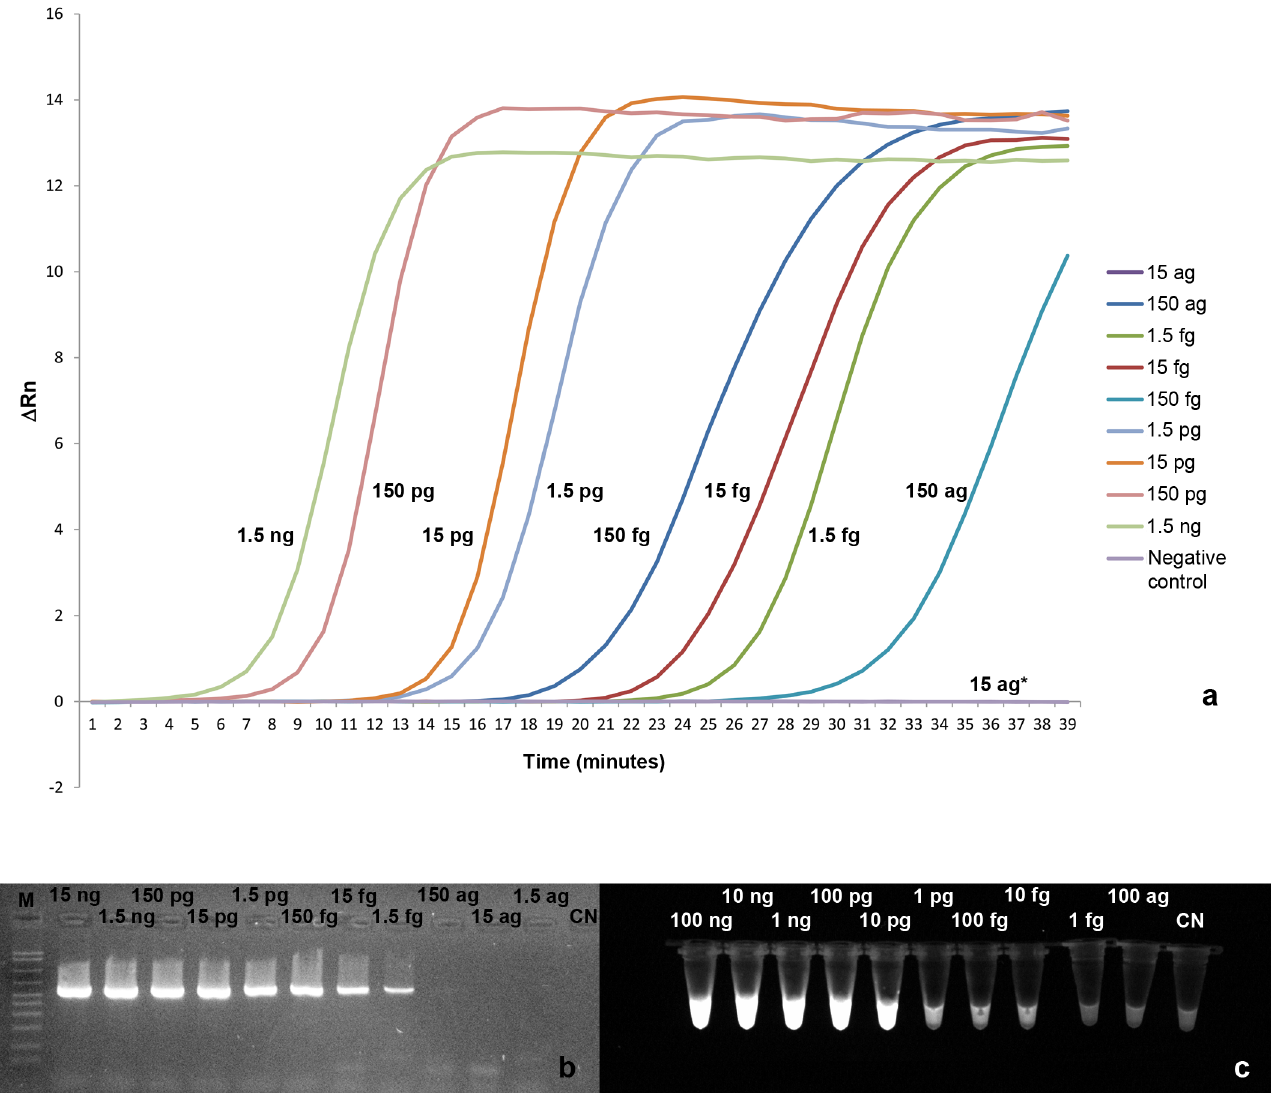
Fig 4. Results of the sensitivity assay. a) ReT-LAMP. The curves represent the Δ Rn after subtraction of the ROX reference dye fluorescence. The amount of D . repens DNA for each reaction is indicated near the respective curve. * The curves of the reaction with 15 ag of DNA and of negative control are overlapping. b) PCR. M: AmpliSize Molecular Ruler, 50 – 2,000 bp Ladder (BioRad Laboratories, Milan, Italy). c) PI-LAMP. The bright fluorescence indicates the positivity of the